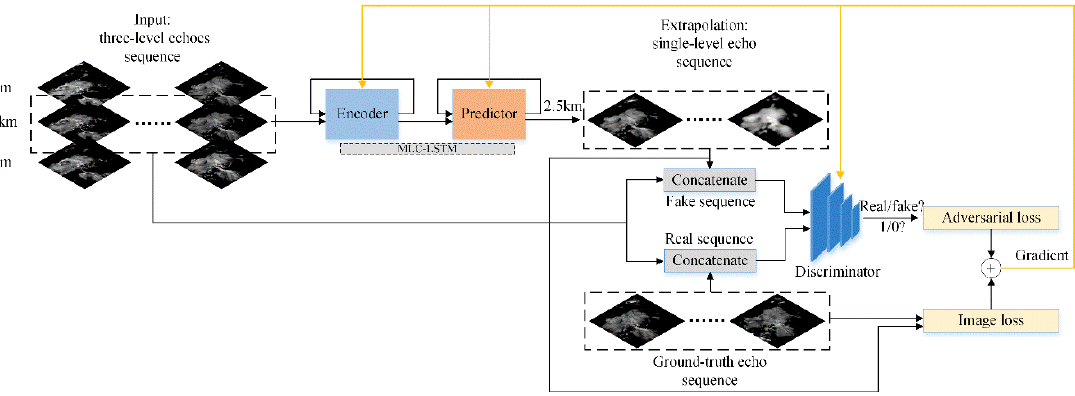
Figure 1. Model overview.